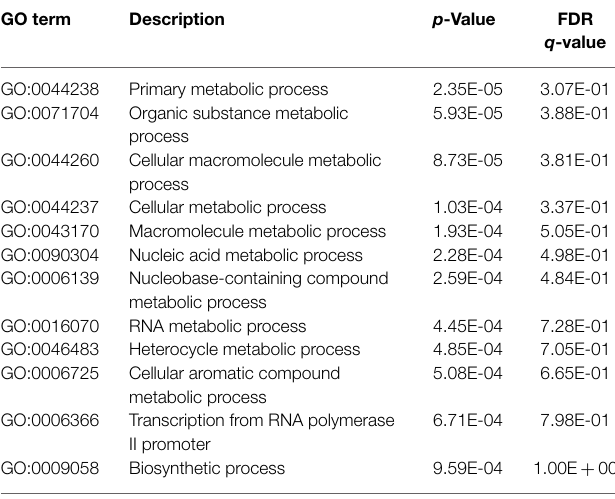
TABLE 2 | ERR alpha associated gene ontology (GO) terms